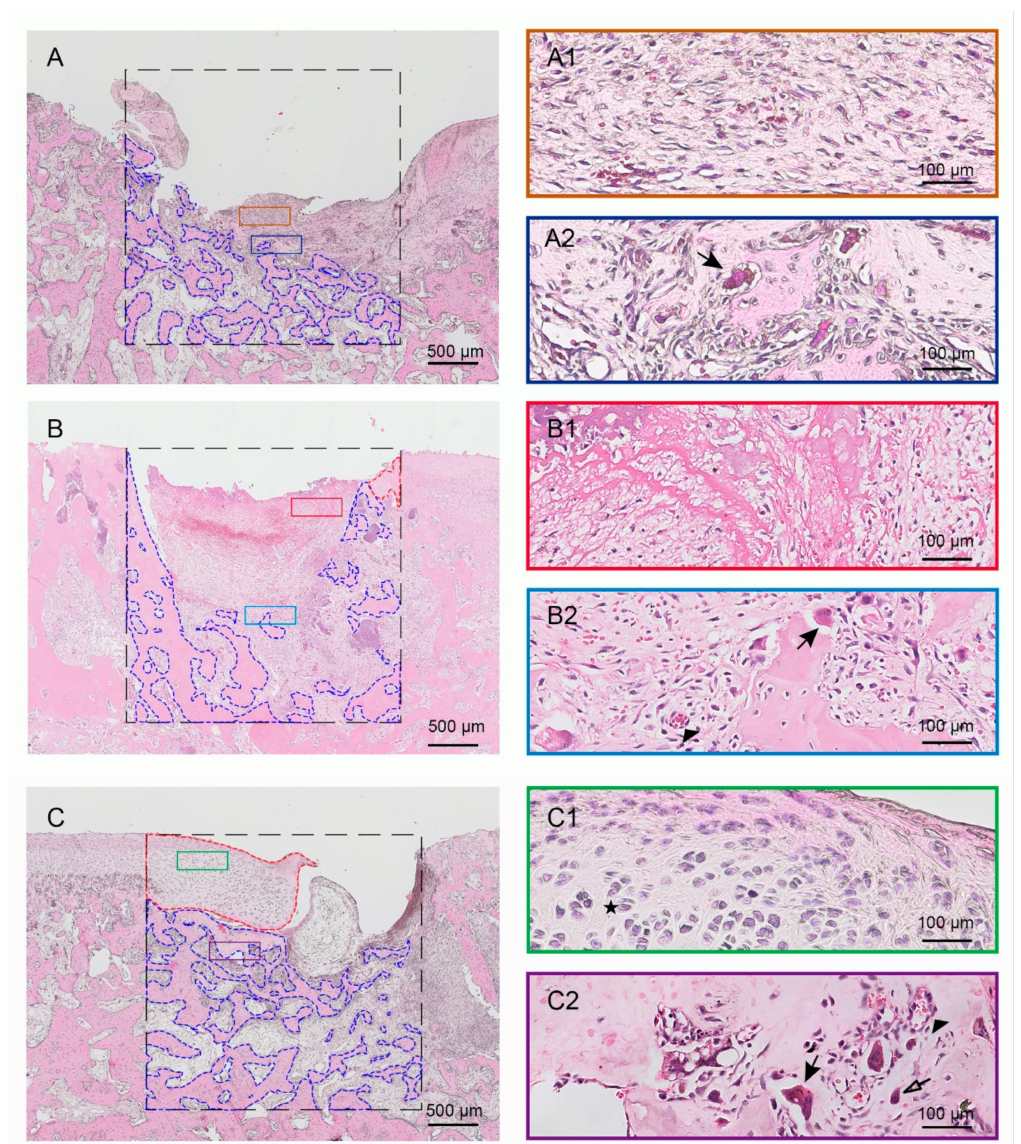
Figure 4. Light micrographs of H&E-stained tissue sections of rabbit condyles with critical-size (3 mm in diameter and 3 mm in depth) osteochondral defects that were treated as control group ( A , A1 , A2 ), Gel-MA group ( B , B1 , B2 ) and Hst1/Gel-MA group ( C , C1 , C2 ). The tissues were retrieved at 4 weeks and then subjected to histologic processing and sectioning. The dotted square area is the original defect area (3 mm × 3 mm). The newly formed cartilage is delineated by the red dotted line, and the new subchondral bone is delineated by the blue dotted line. Solid arrow: osteoclasts; hollow arrow: osteoblasts; black star: immature cartilage cells; triangle: neovascularization. Scale bar = 500 µ m in A – C ; Scale bar = 50 µ m in A1 – C2